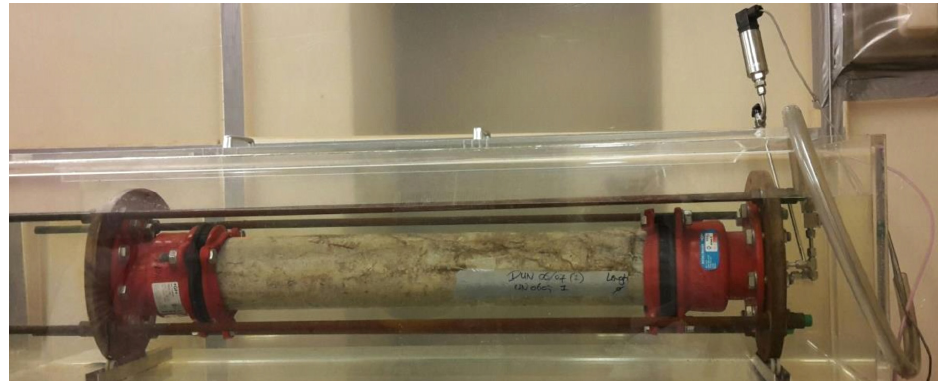
Figure 1. Test rig for the strength tests. Table 2. Summary of pipe segment